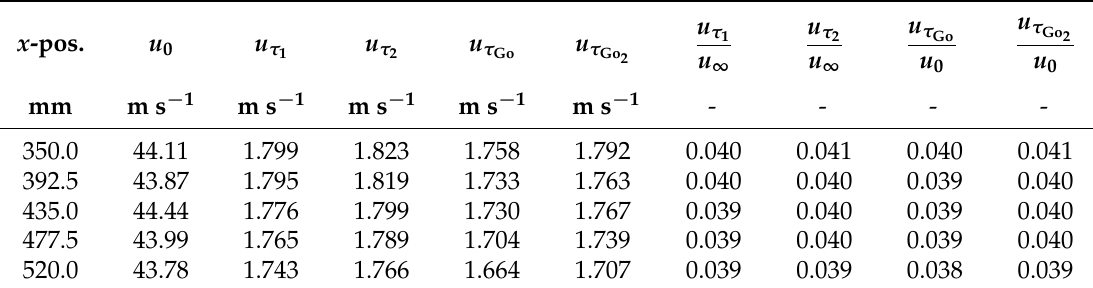
Table 2. Comparison of the boundary layer parameters to analytical approaches and to the curve fitting beyond the approach of